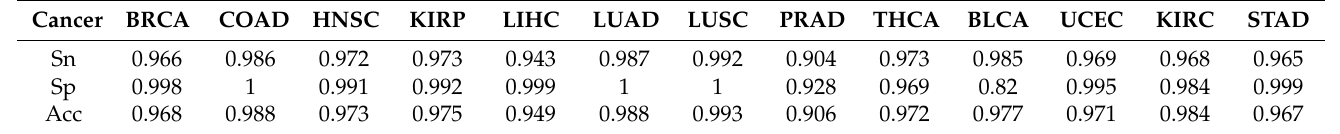
Table 2. The performance of the random forest classifier based on PDSs in 13 types of cancer.